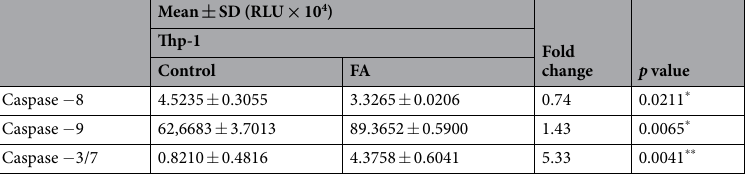
Table 2. Effect of FA on caspase ( − 8, − 9, − 3/7) activity in Thp-1 cells. SD: standard deviation; RLU: relative light units; * p < 0.05; ** p <